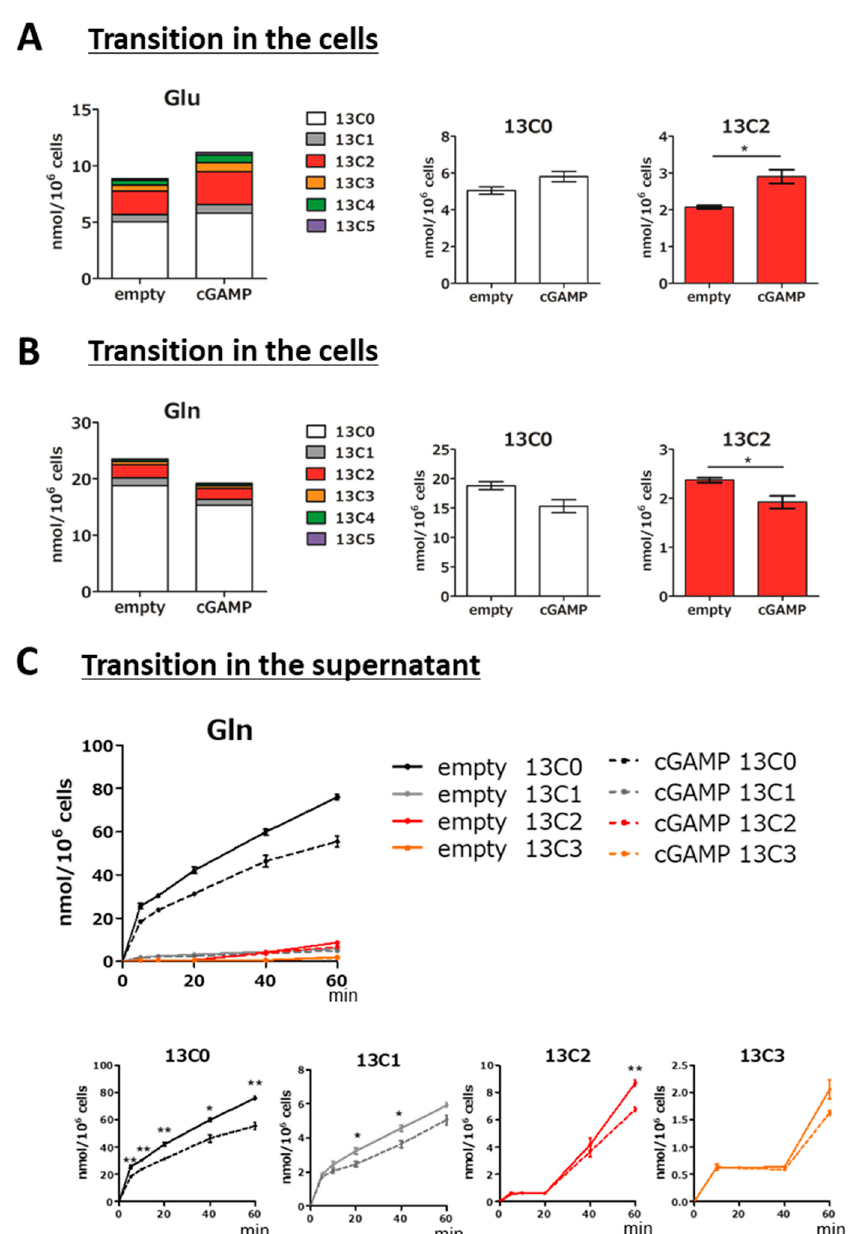
Figure 3. Evaluation of Glu and Gln metabolism in astrocytes incorporating cGAMP using 13 C6-glucose. ( A ) The amount of Glu in cGAMP-incorporated astrocytes after 60 min of 13 C6-glucose addition. ( B ) The amount of Gln in cGAMP-incorporated astrocytes after 60 min of 13 C6-glucose addition. ( C ) Transition in the amount of Gln in the supernatant of cGAMP-incorporated astrocytes up to 60 min after 13 C6-glucose addition. ( A – C ) * p < 0.05, ** p < 0.01, empty vs. cGAMP at each time point (n = 3, Student’s t ‐ test).